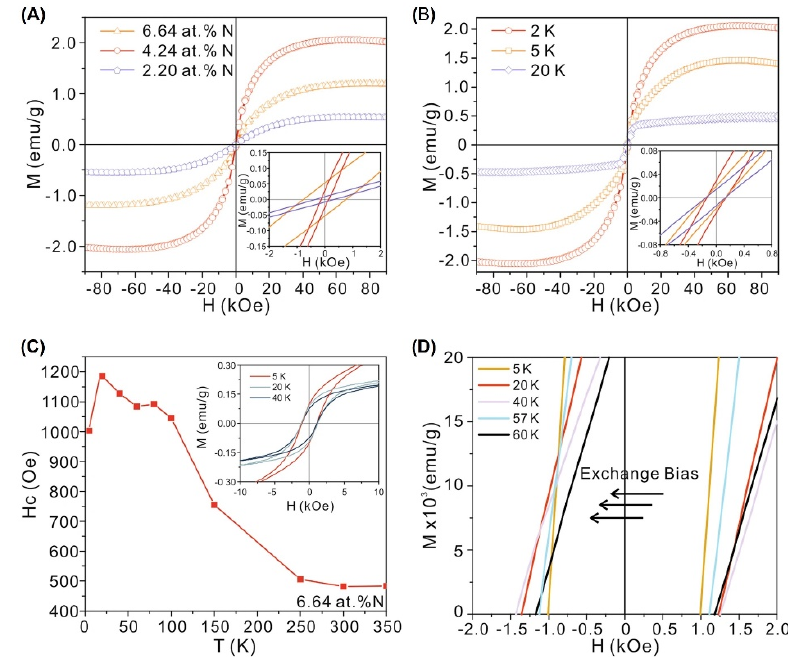
Figure 7. M − H of ReN x with different nitrogen doping concentrations and detailed analysis with temperature evolution. ( A ) M − H of ReN x at 2K; the inset shows the non − zero coercivity around the origin. ( B ) M − H of ReN 4.24 at low temperatures. ( C ) H c vs T of the ReN 6.64 sample. The inset shows the exchange bias around the Néel point. ( D) Magnified view of the M − H of ReN 6.64. (Reproduced with permission from [18]. Copyright 2018, Springer Nature.)